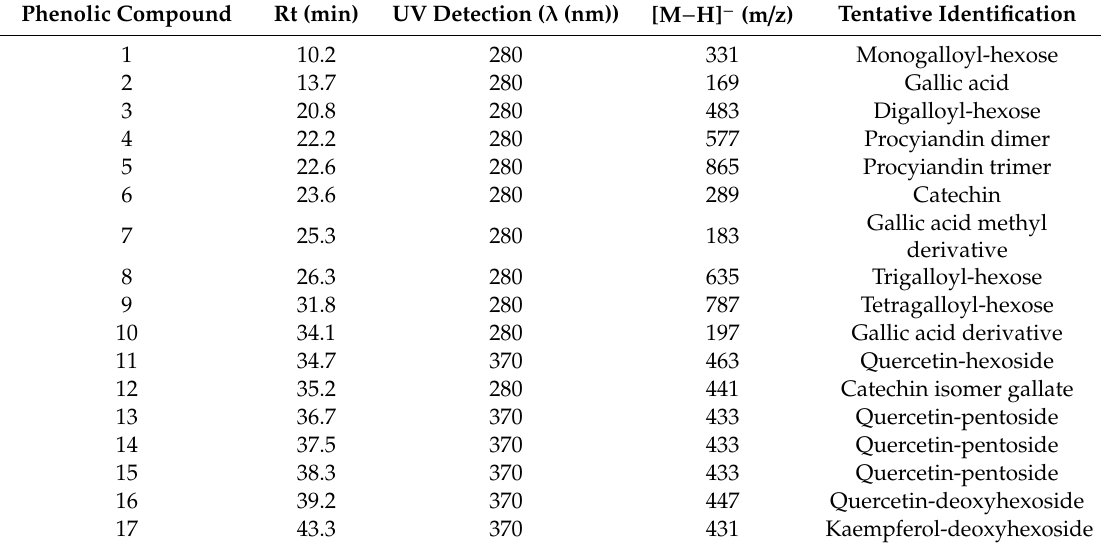
Table 1. Identification of phenolic compounds in the carob seed extracts.